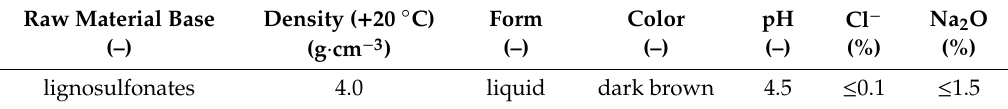
Table 6. Properties of plasticizing admixture.